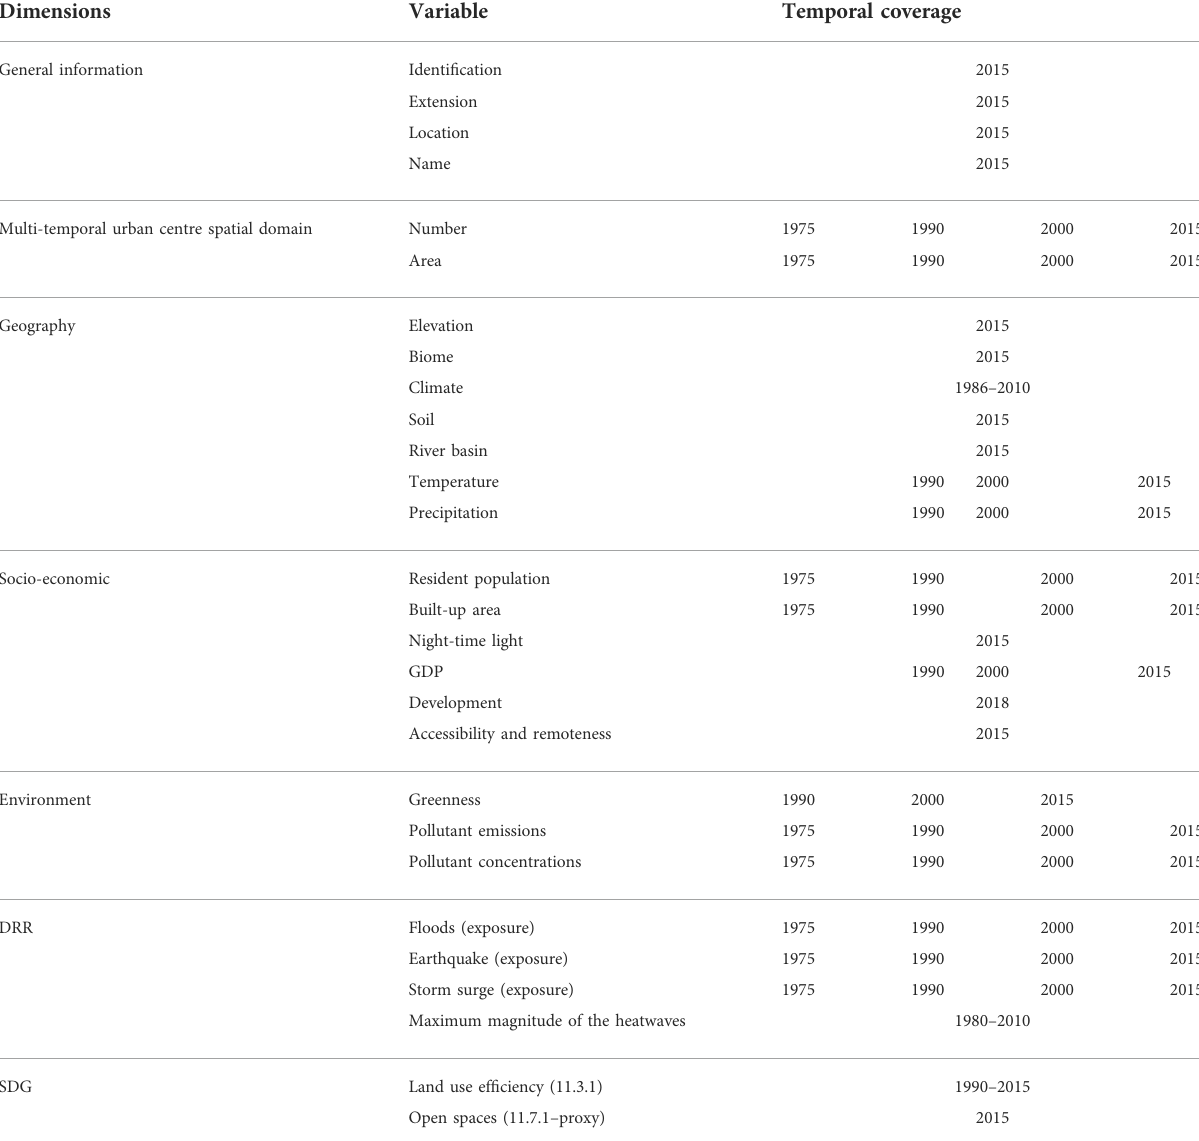
TABLE 1 Overview of the dimensions and variables in the Urban Centre Database 2015 and their temporal extent.